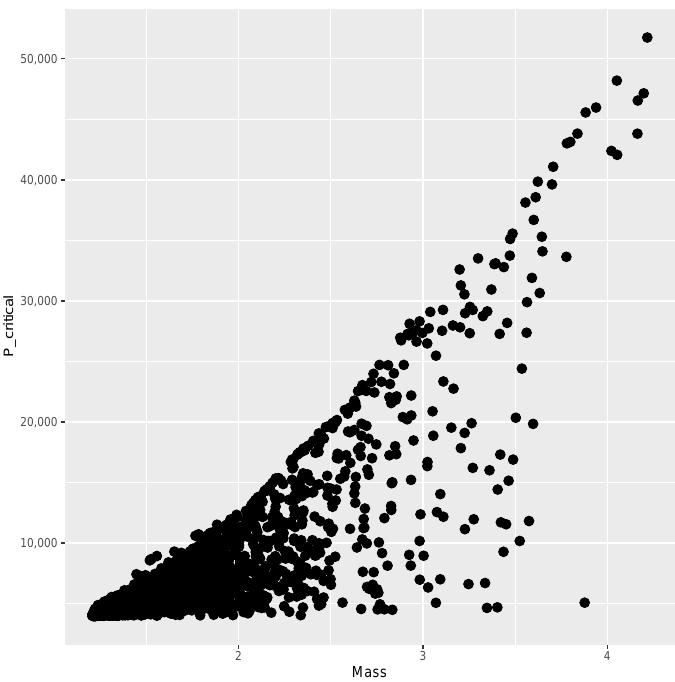
Figure 4. Mass and P critical of sample